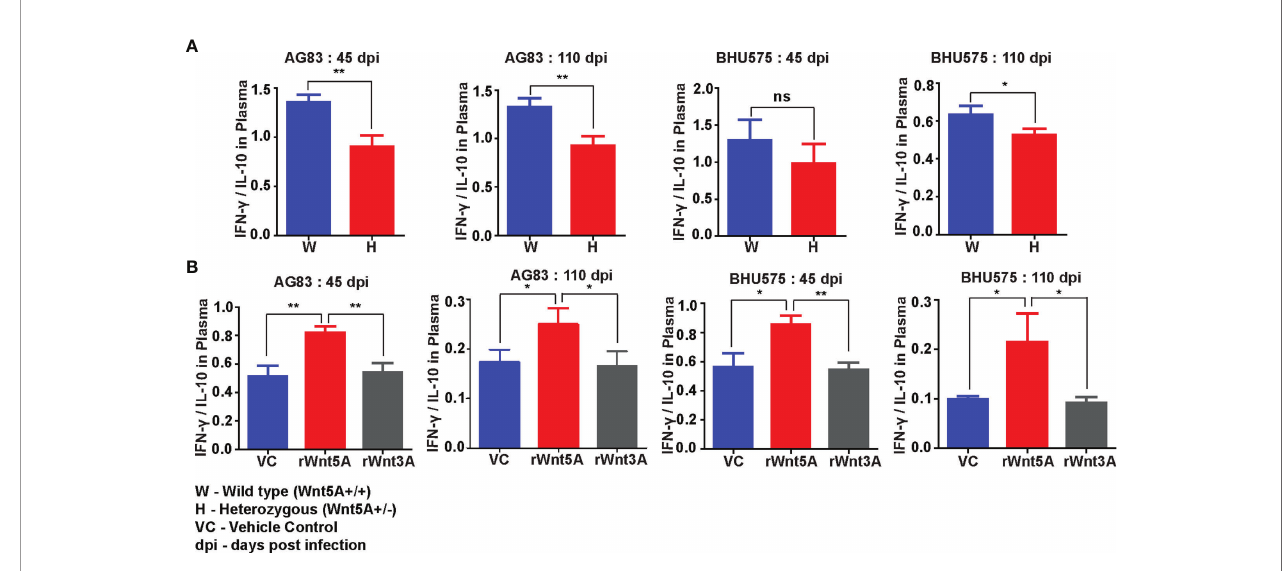
FIGURE 8 | rWnt5A promotes a IFN- g /proin fl ammatory bias cytokine during L. donovani infection. (A) Graphical representation of higher IFN- g /IL-10 ratio in the blood plasma of AG83 and BHU575 infected Wnt5A+/+ (W) mice as compared to Wnt5A+/- (H) mice. (B) rWnt5A treatment before AG83 or BHU575 infection correlates with higher plasma IFN- g /IL-10 in comparison to rWnt3A or VC treatment. Statistical analysis was performed with the unpaired t-test. Data are presented as mean ± SEM. Signi fi cance was annotated as follows: * p ≤ 0.05, ** p ≤ 0.005, ns, not signi fi cant, n=6 (per